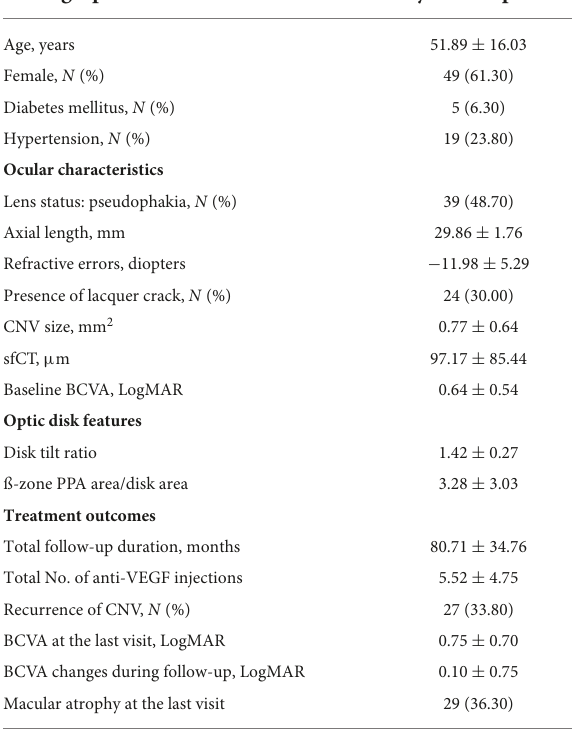
TABLE 1 Baseline demographics and ocular characteristics of the patients in this study and their treatment outcomes at the last